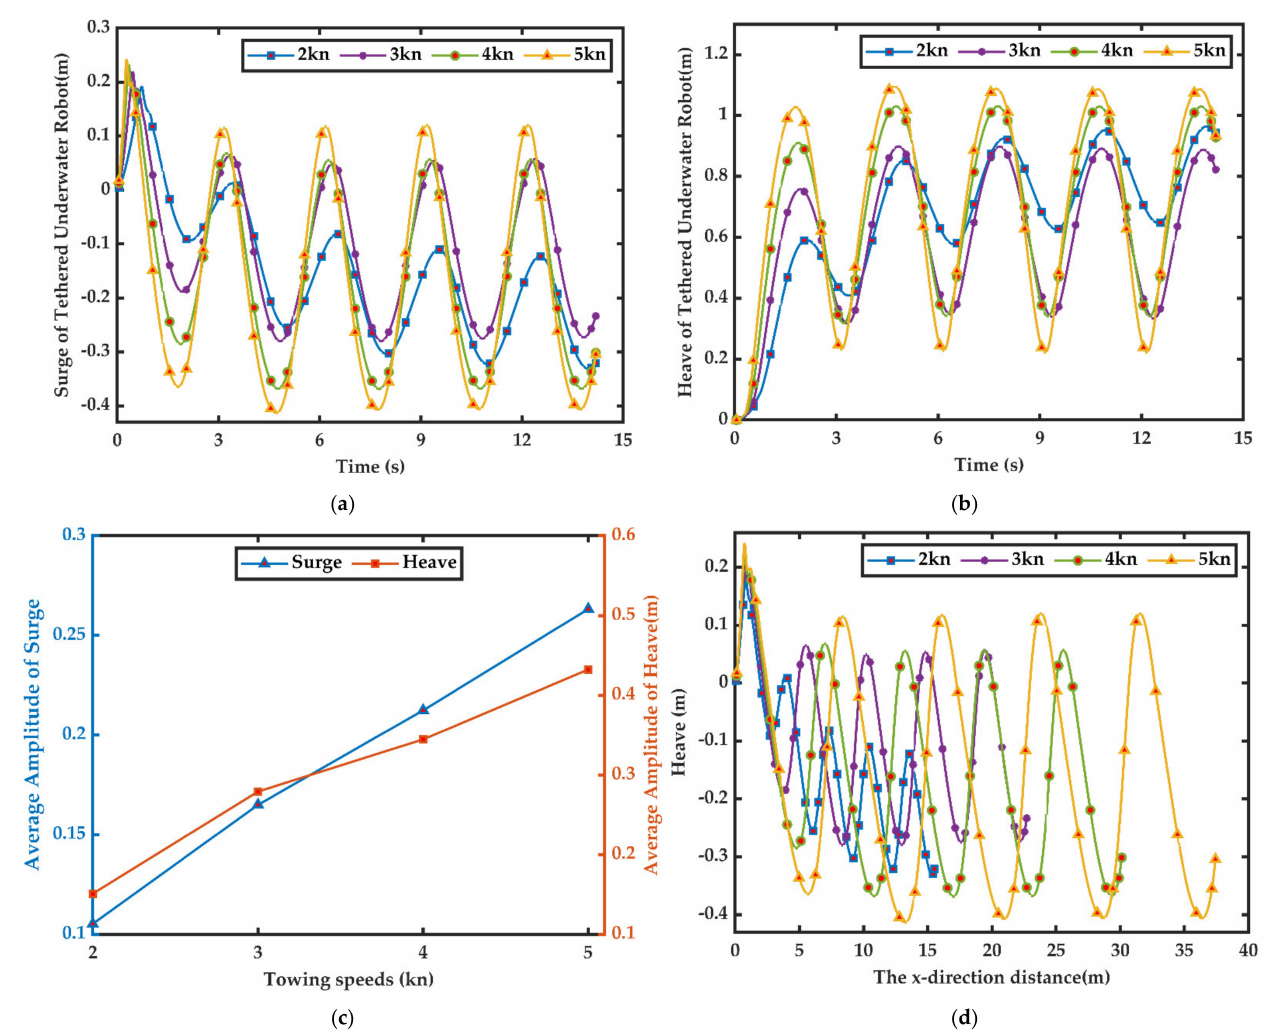
Figure 7. Time history of the trajectory of the tethered underwater robot at different towing speeds: ( a ) the tethered underwater robot’s surge; ( b ) the tethered underwater robot’s heave; ( c ) the average amplitude of surge and heave; ( d ) the trajectory of the tethered underwater